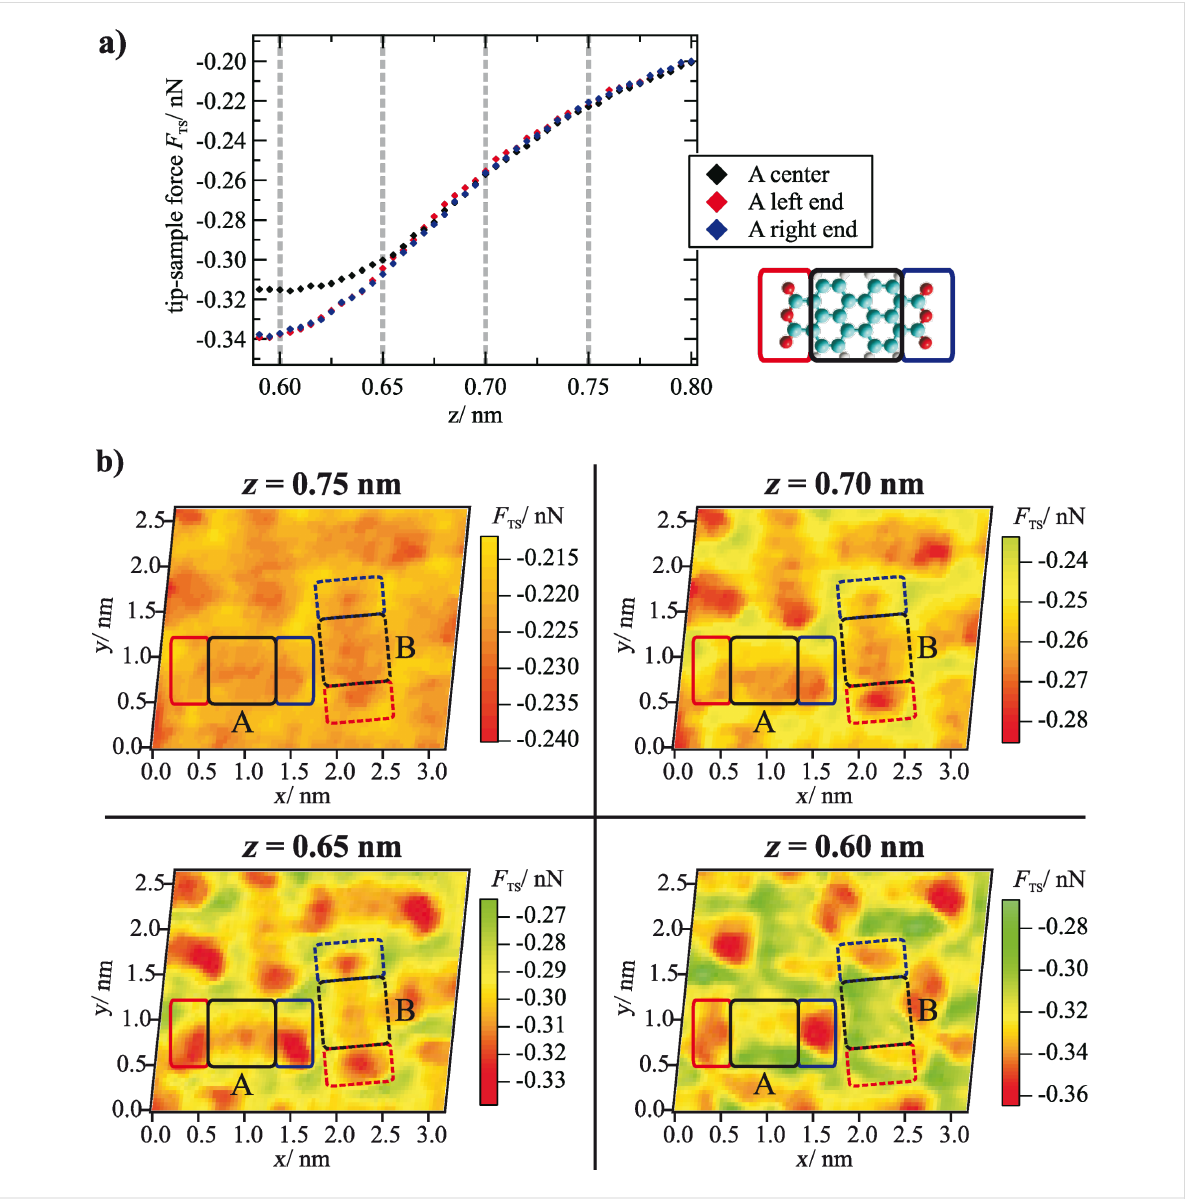
Figure 3: (a) Tip–sample forces as a function of z distance averaged for the area above the end groups and the center of a molecule (here: orienta- tion A) as indicated by colored rectangles in the sketch on the right side. (b) Horizontal cuts through the 3D force field at different z distances that are marked by gray dashed lines in the F TS ( z ) curves in (a). In the cuts at z = 0.65 nm and z = 0.60 nm, a clear intramolecular contrast can be observed. In addition, at z = 0.60 nm, differences between the two molecule orientations appear. For all cuts, the color-force gradient is the same. However, the minimum of the color scale was adjusted to match the minimum force value within the cut. Furthermore, a slight linear interpolation with a factor of 2 was applied.